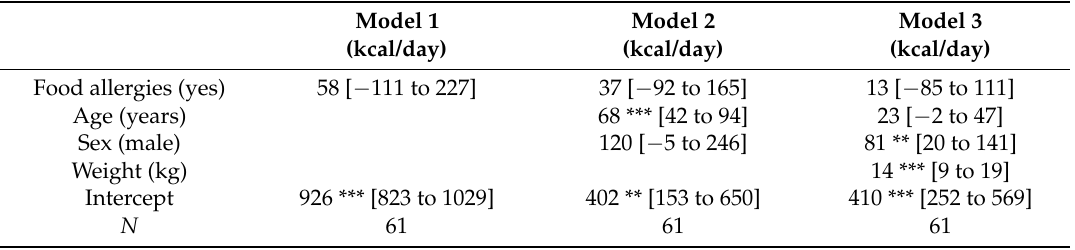
Table 5. Association between food allergies and resting energy expenditure (REE): 75th percentile regression equations. Model 1 Model 2 Model 3 (kcal/day) (kcal/day) (kcal/day) Food allergies (yes) 71 [ − 123 to 265] 69 [ − 49 to 187] 115 ** [45 to 185] 49 ** [20 to 79] 9 [ − 29 to 46] Sex (male) 26 [ − 86 to 138] 102 * [18 to 186] Weight (kg) 13 * [1 to 26] Intercept 1180 *** [1033 to 1327] 729 *** [496 to 963] 595 *** [381 to 810] 61 61